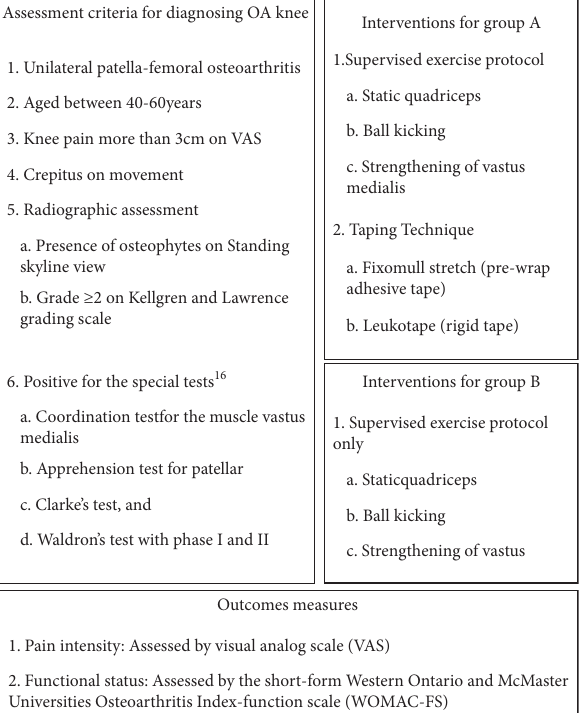
Figure 1: A brief explanation of the assessment, diagnostic criteria, interventions, and outcomes of the